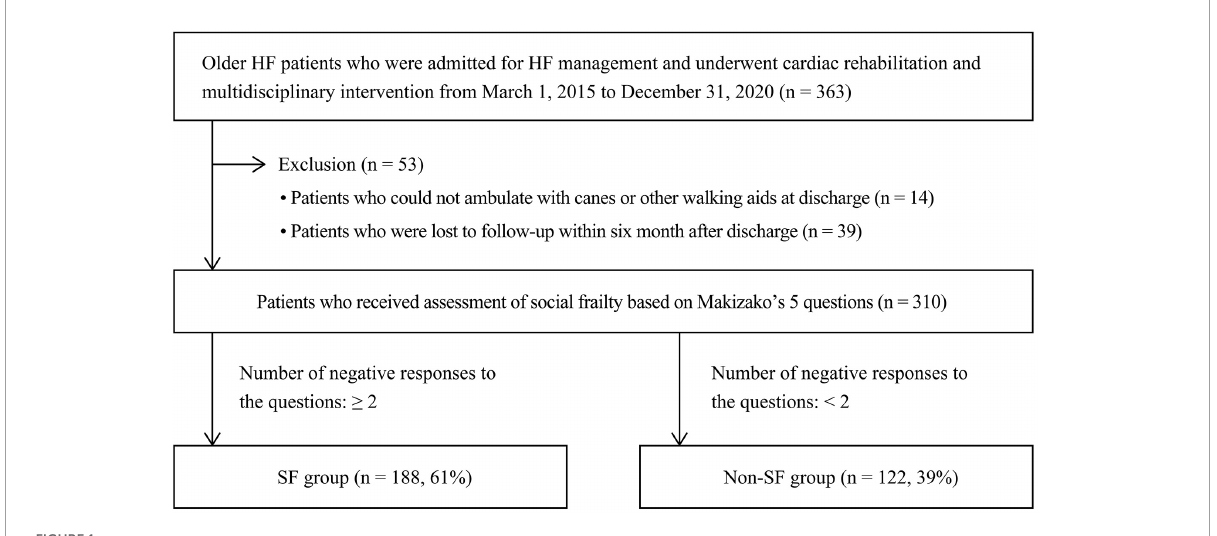
FIGURE1 Flow chart of the inclusion of study subjects. HF, heart failure; SF, social